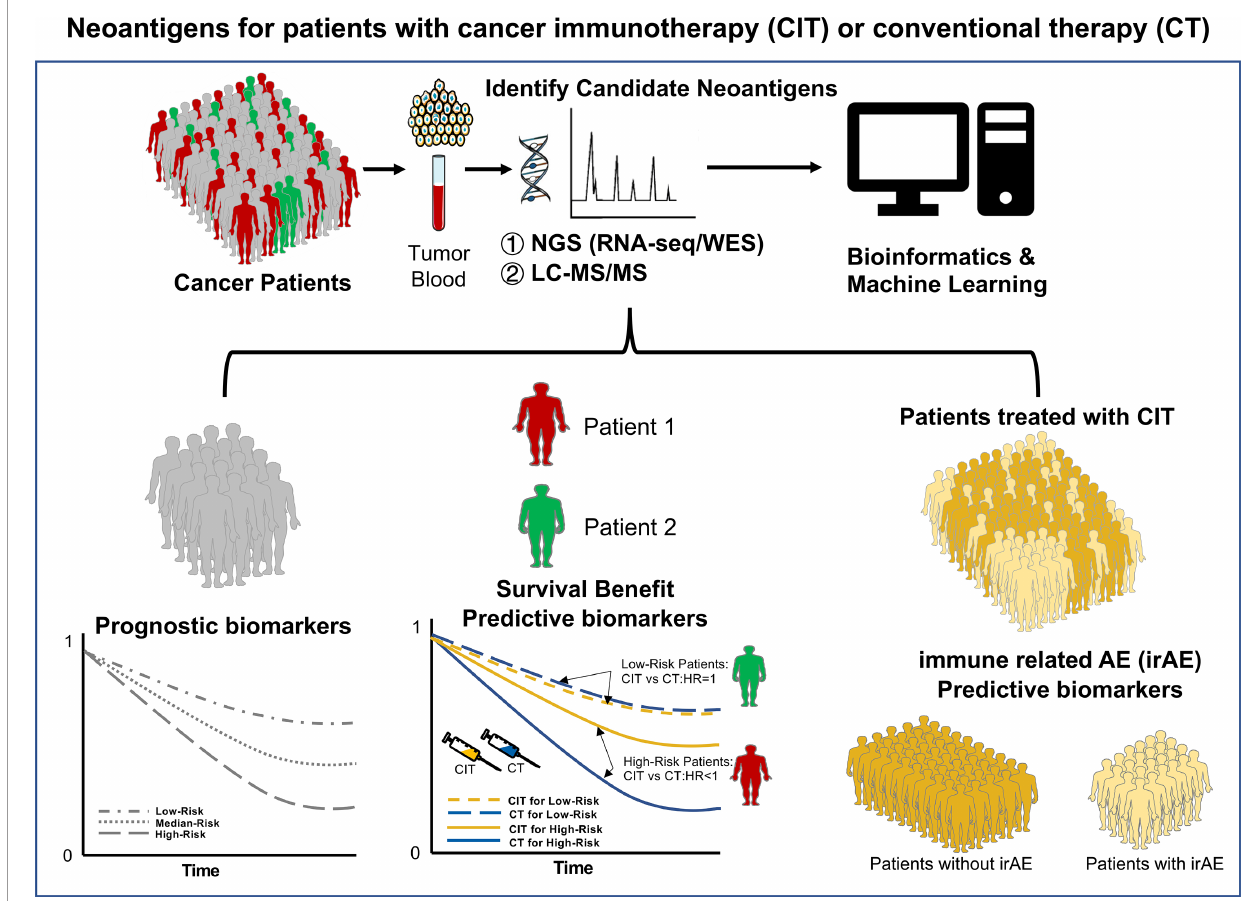
FIGURE 1 | Neoantigens as potential biomarkers for cancer patients treated with immunotherapies and/or conventional therapies. Neoantigens are mostly derived from mutations in tumor cells. The candidate neoantigen can be identi fi ed from tumor tissue and blood samples with bioinformatics analysis ① . Next- Generation Sequencing (NGS), including RNA-sequencing (RNA-seq), whole-genome sequencing (WGS), and whole-exome sequencing (WES); ② . Liquid chromatography-mass spectrometry (LC-MS). They can serve as three major potential biomarkers. First, as a prognostic biomarker which indicates an increased (or decreased) likelihood of a future clinical event, disease recurrence, or progression in an identi fi ed population. Predictive biomarkers are used to identify individuals who are more likely than similar individuals without the biomarker to experience a favorable or unfavorable effect from exposure to a medical product or an environmental agent. Safety biomarkers are measured before or after an exposure to a medical product or an environmental agent to indicate the likelihood, presence, or extent of toxicity as an adverse effect. Figure modi fi ed with text, markings (stars), and annotation after adapted